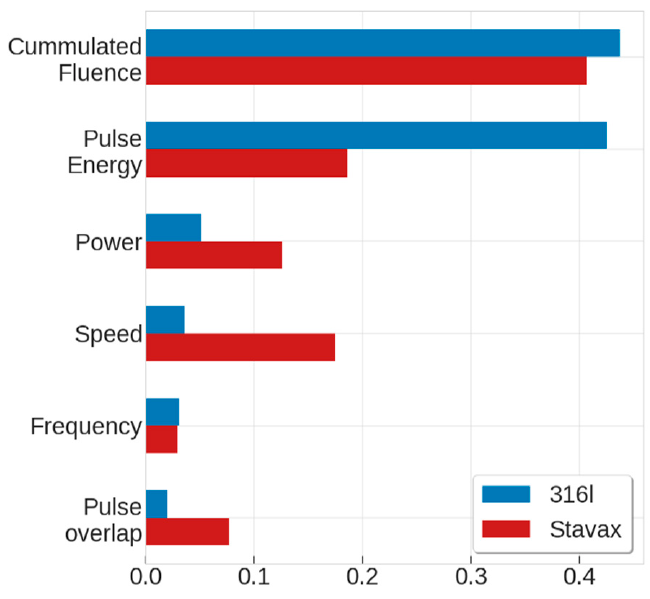
Figure 4. Relative feature importance of the input parameter for the prediction using random forest approach.